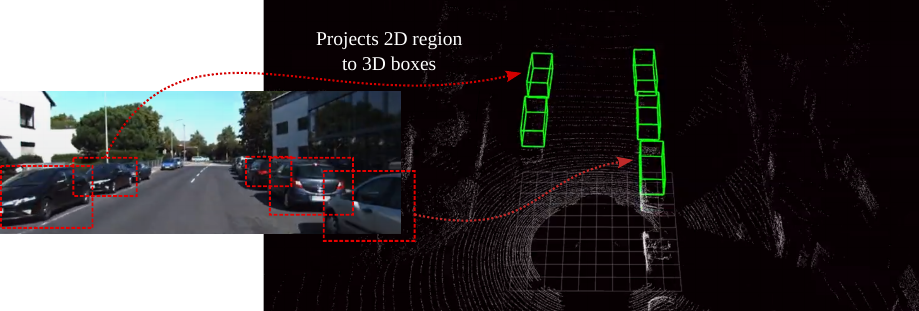
Figure 6. Multi-modal model Frustrum PointNets [100] which uses CNN model to projects detected objects from RGB images into 3D space, thus improving the accuracy on semantic